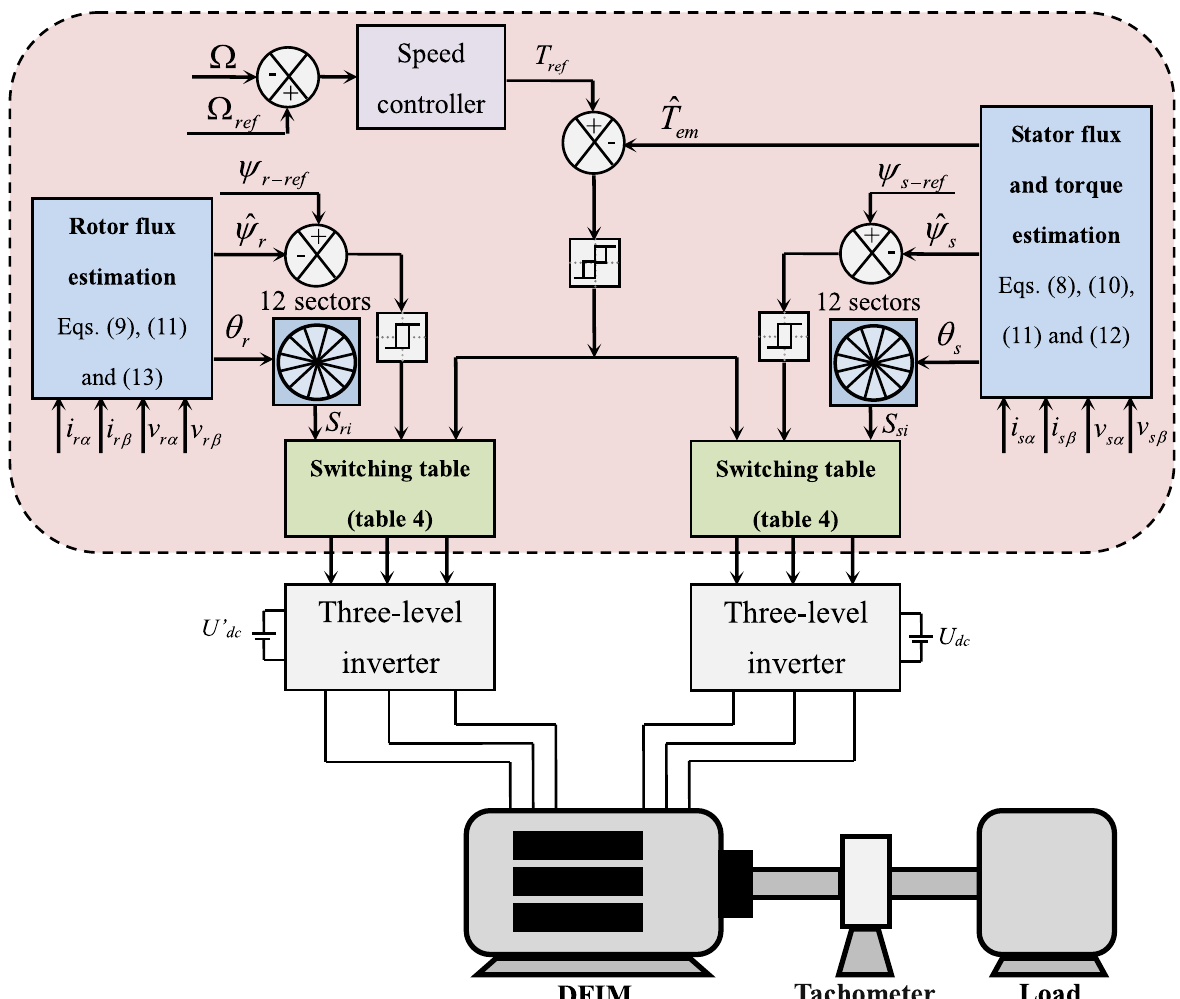
Fig. 6 DTC strategy of DFIM connected to two